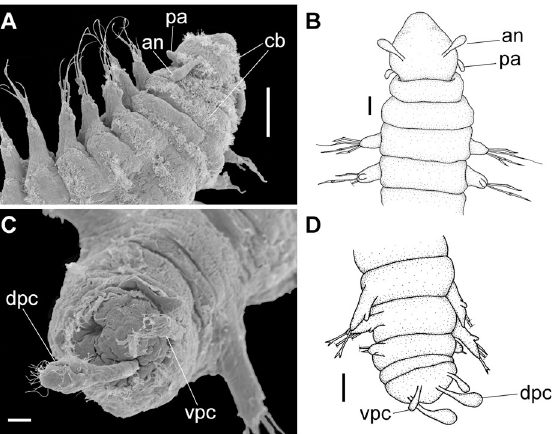
cirrus. Scale bars: (A) = 50 μ m; (B,D) = 25 μ m; (C) = 10 μ m.